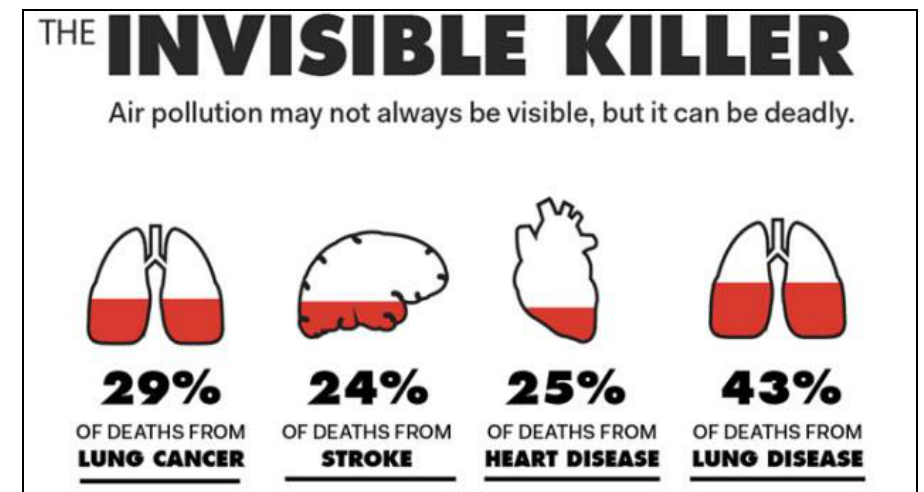
Fig. 7: Ambient air pollution death related diseases (WHO, 2020a)